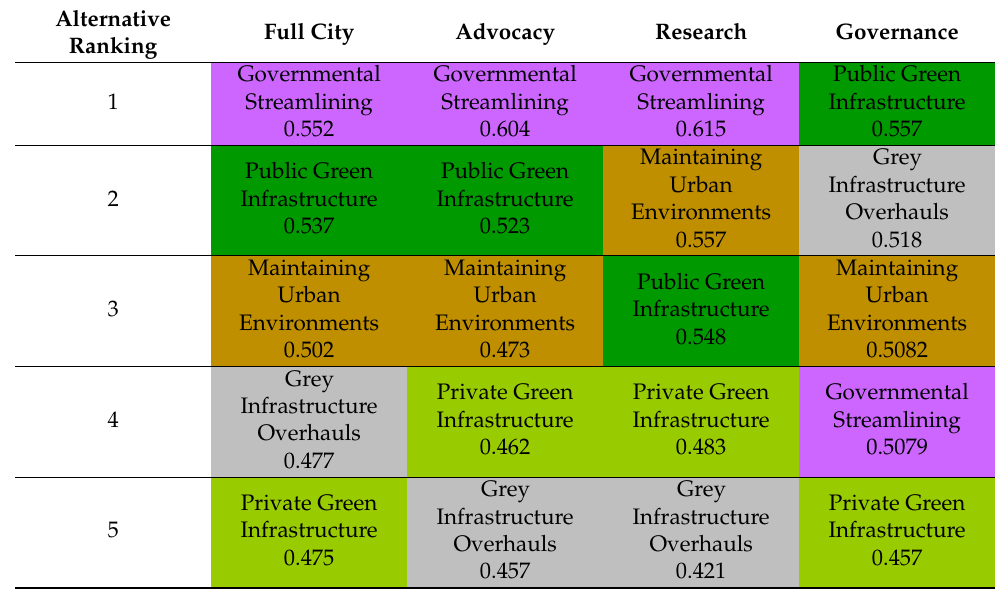
Table 5. The resulting TOPSIS scoring and alternative ranking in New York City stormwater for the full city and stakeholder groupings. Each color represents one of the five policy